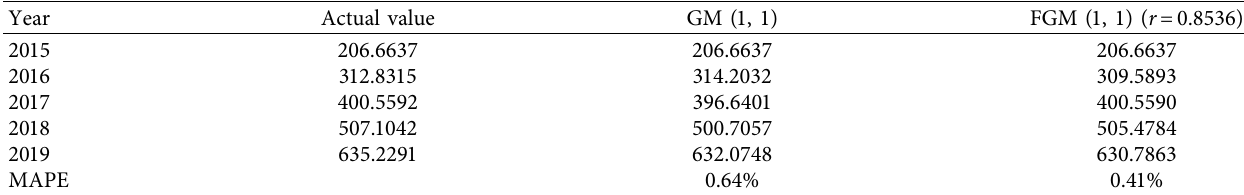
Table 1: The MAPE of GM (1, 1) model and FGM (1, 1) model (100 million pieces).